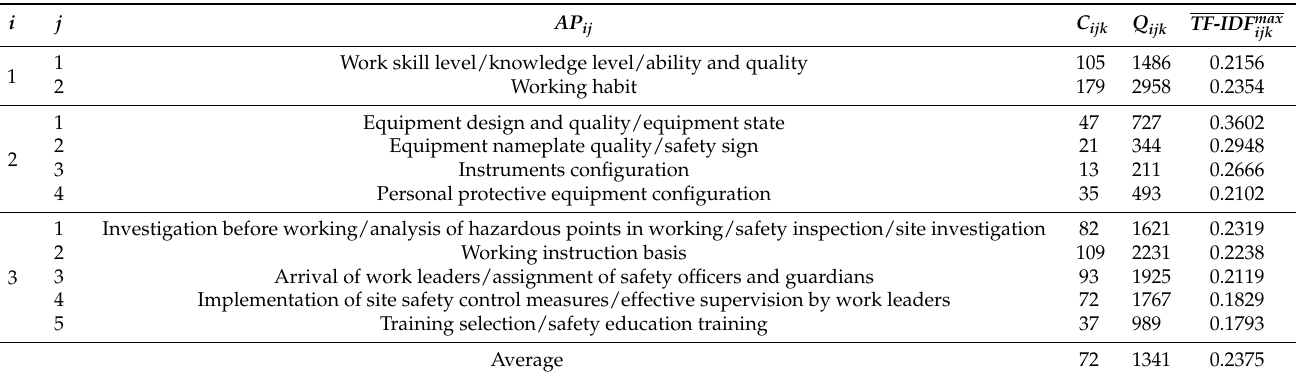
Table 3. Screening Results of Key Hidden Danger Factors of Electric Power Personal Casualty Accidents Based on Term Frequency